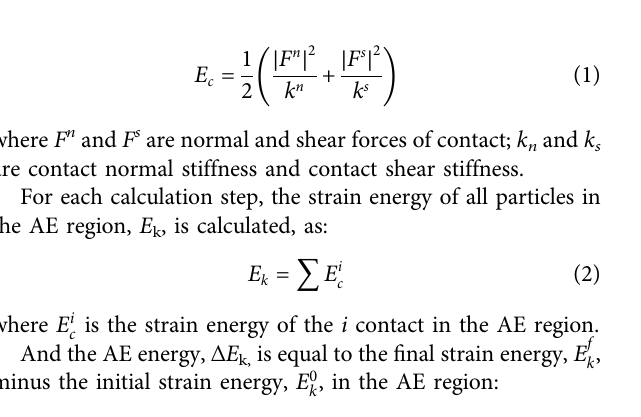
Frontiers in Physics |